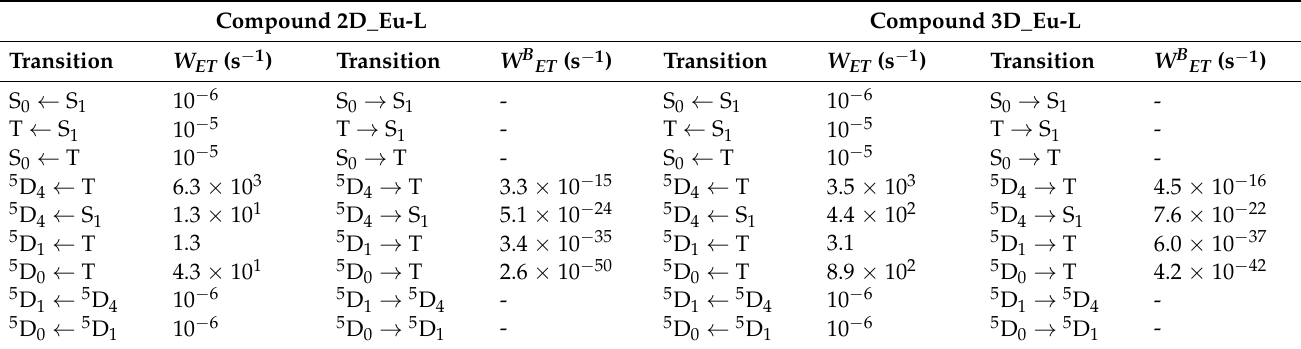
Figure 7. Schematic diagram of the main states and transfer rates involved in the luminescence of compounds: ( a ) 2D_Eu-L and ( b ) 3D_Eu-L . Table 6. Transfer rates calculated for the transitions of compounds 2D_Eu-L and 3D_Eu-L .